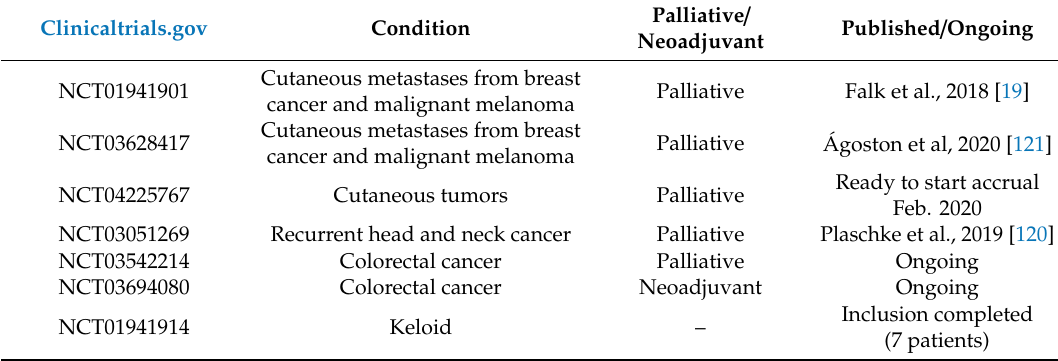
Table 2. Clinical trials with calcium